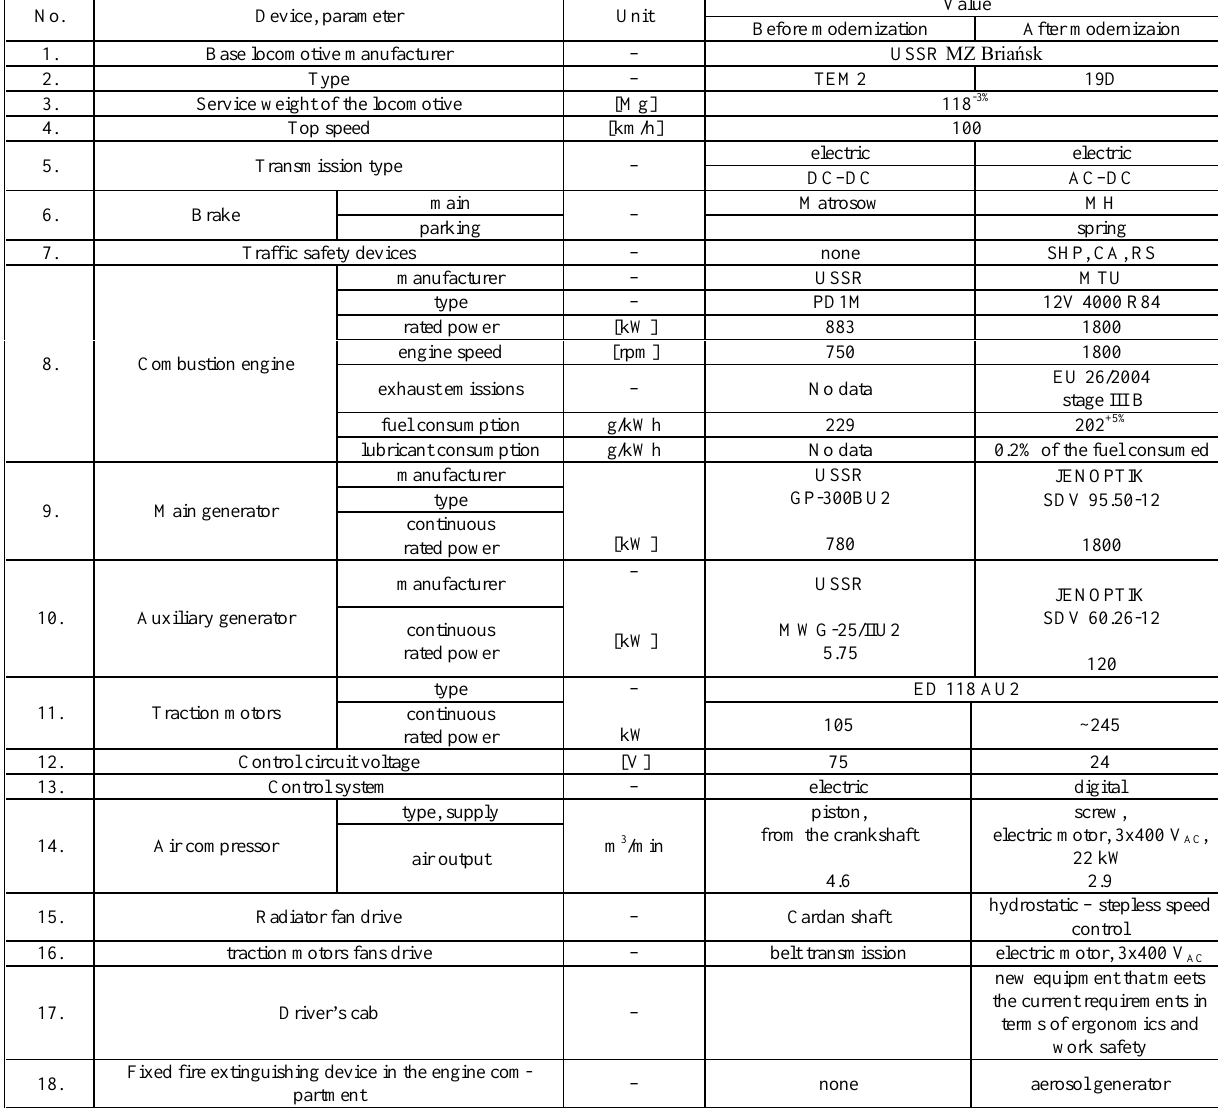
Fig. 14. Example of exhaust emission for a diesel engine of the locomotive SM48 (19D) Table 1. Basic locomotive parameters before and after